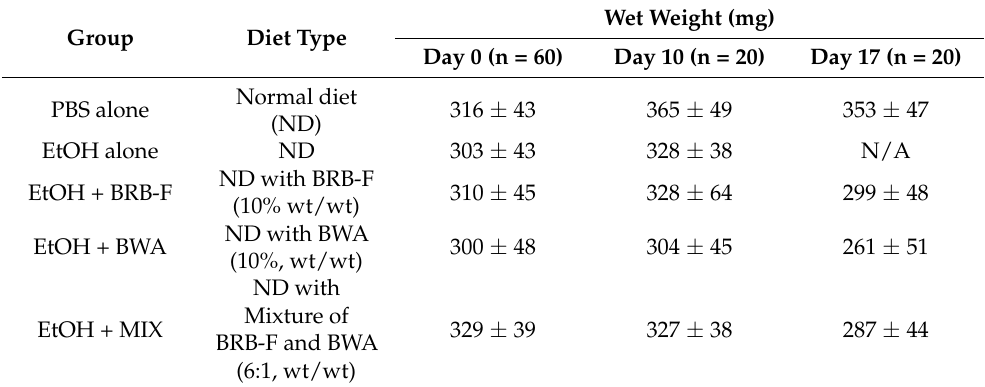
Table 1. Experimental design and changes in body weights during the alcohol exposure period *.